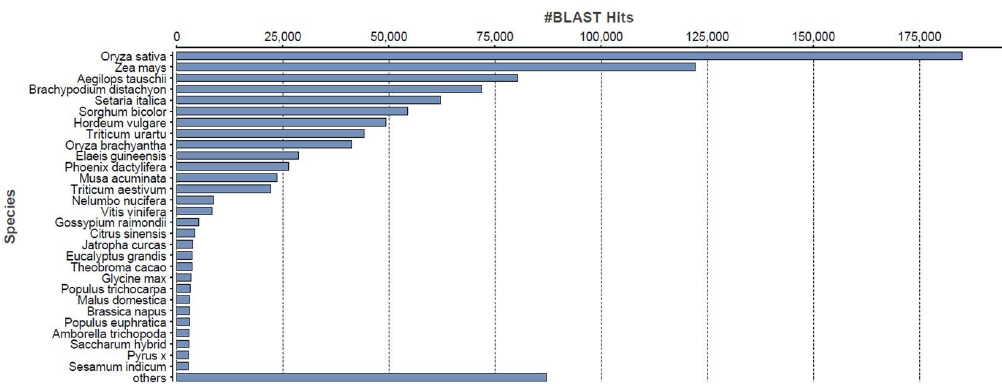
Figure 1. Species-specific distribution of highest matches for gene ontology (GO).